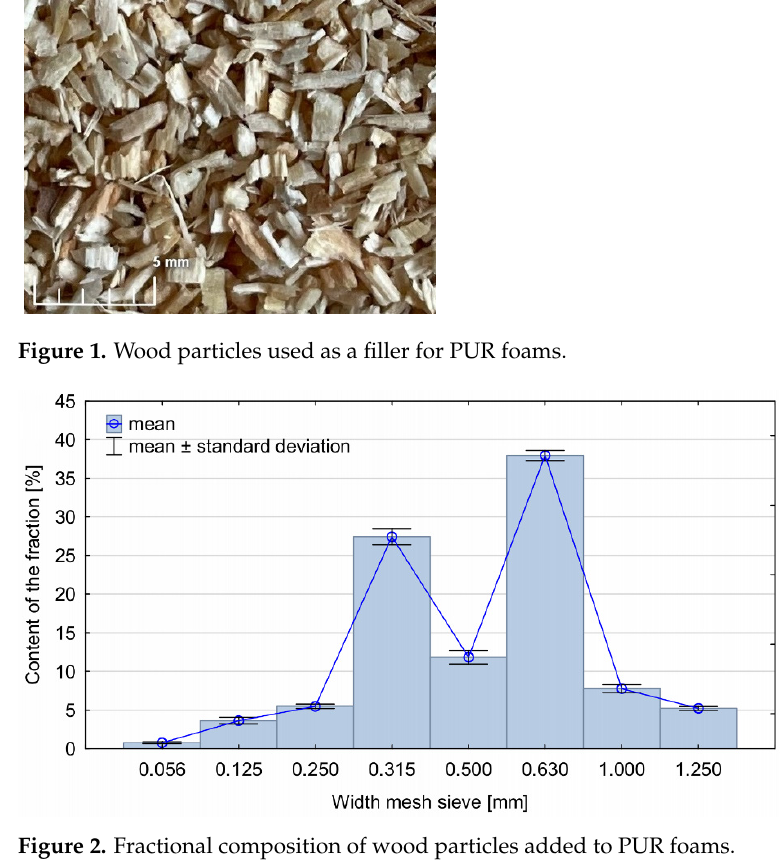
Figure 2. Fractional composition of wood particles added to PUR foams.